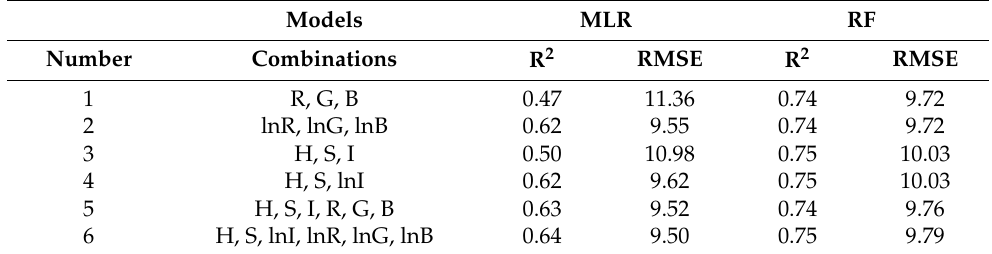
Table 4. Validation results of the models with different variable combinations.